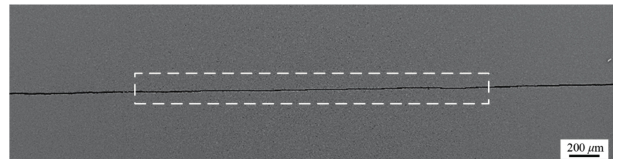
Figure 1. SEM morphology of the